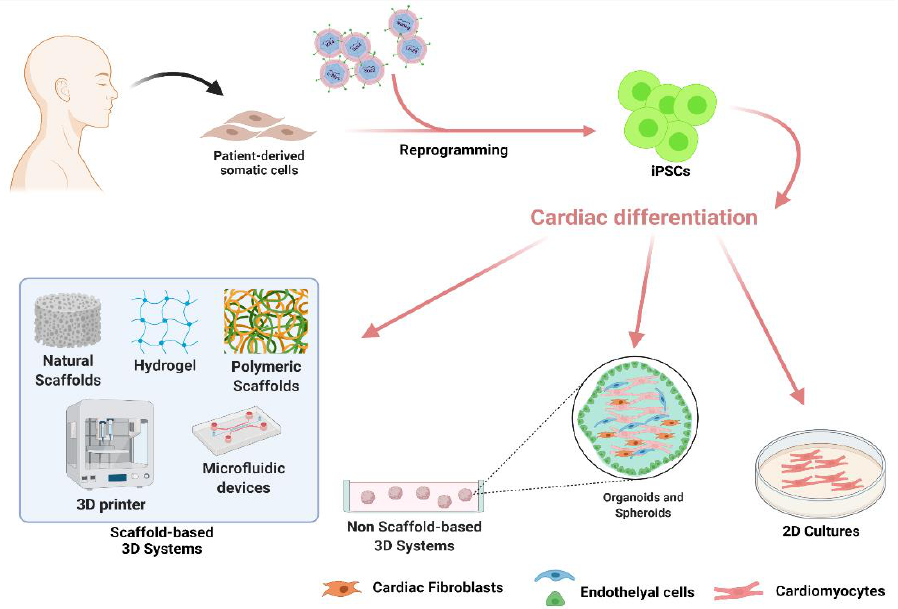
Figure 1. Schematic representation of induced Pluripotent Stem Cells (iPSCs)-derived cardiac cell generation and their possible use in translational medicine. The figure is created with BioRender (https://biorender.com/, accessed on 30 July 2021).